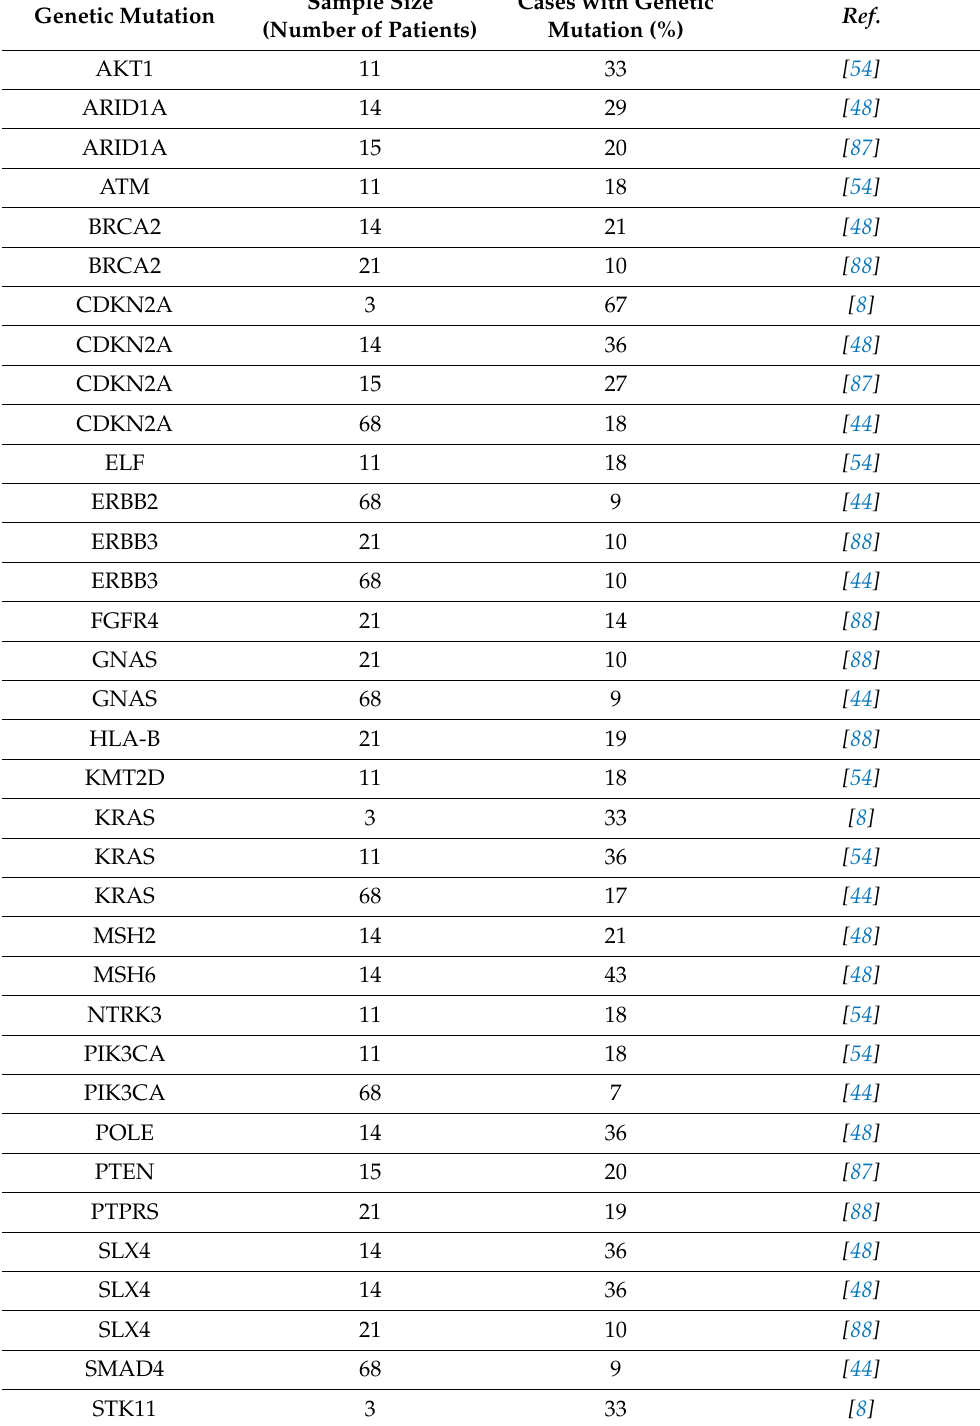
Table 3. Genetic mutations and gene amplification in gastric-type